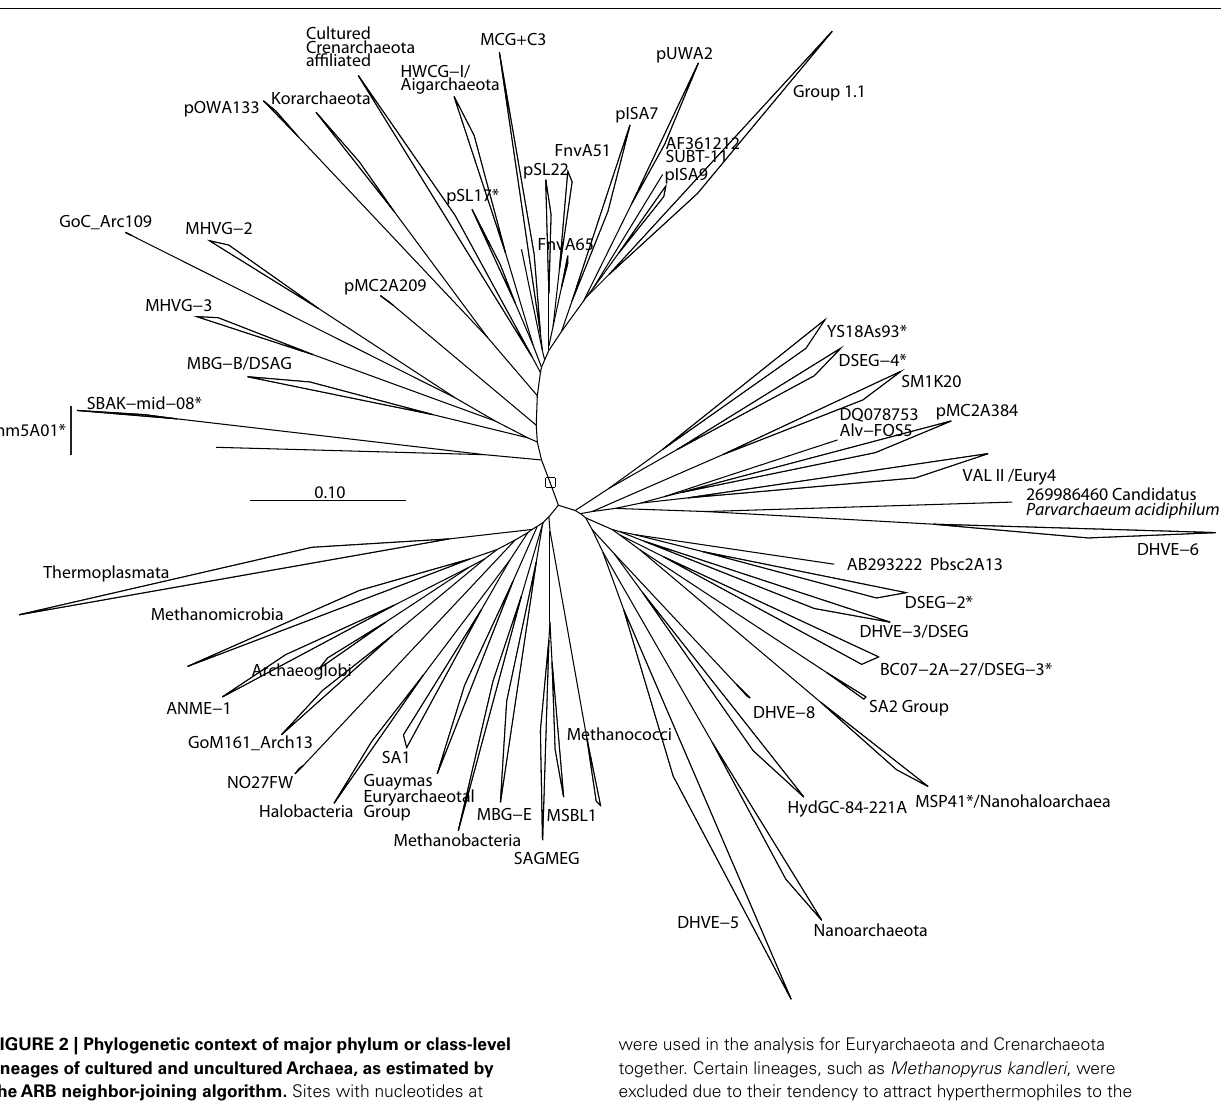
were used in the analysis for Euryarchaeota and Crenarchaeota together. Certain lineages, such as Methanopyrus kandleri , were excluded due to their tendency to attract hyperthermophiles to the base of the